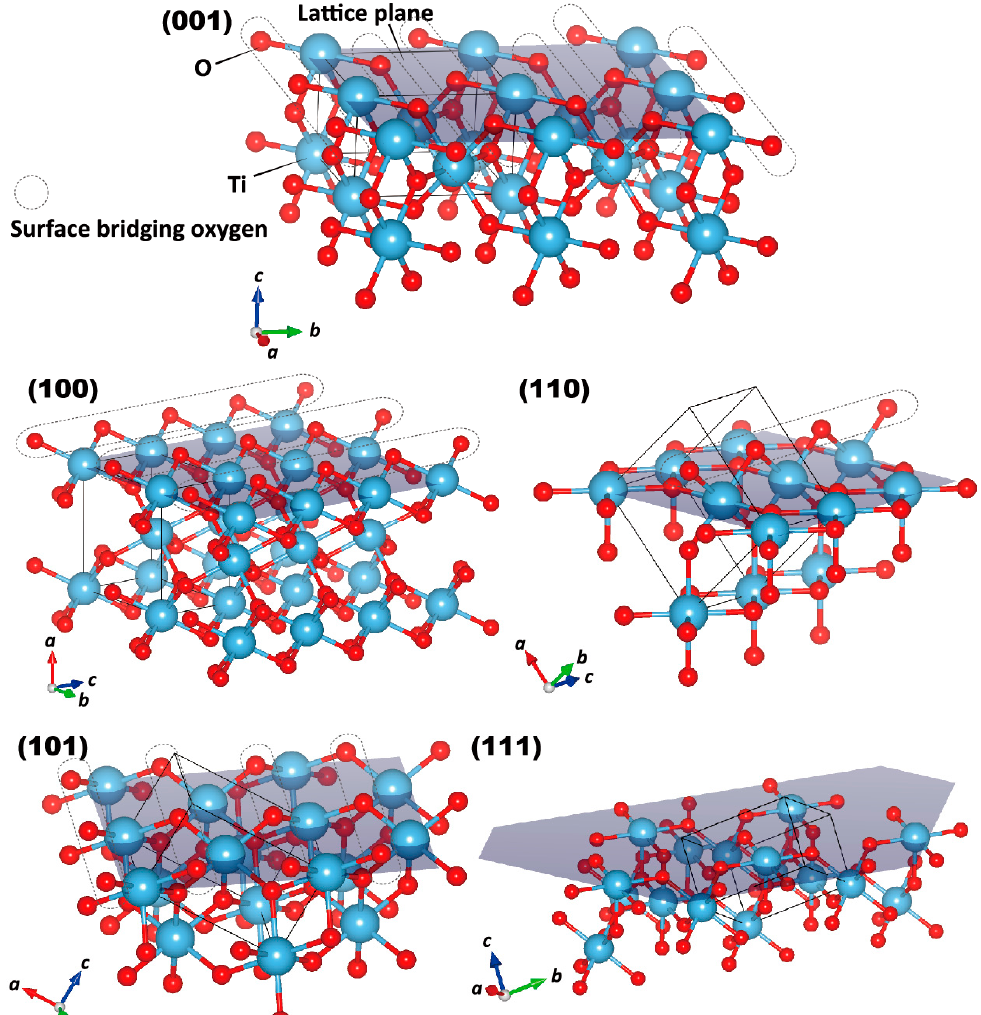
Figure 1. Schematic crystal structures for the (001), (100), (110), (101), and (111) planes of TiO 2 :Nb. The light-blue and red spheres represent titanium and oxygen atoms, respectively. Some of the titanium atoms have been substituted by niobium atoms (0.43 at%). The gray planes and dotted ovals represent the crystal surface and bridging oxygen atoms, respectively.